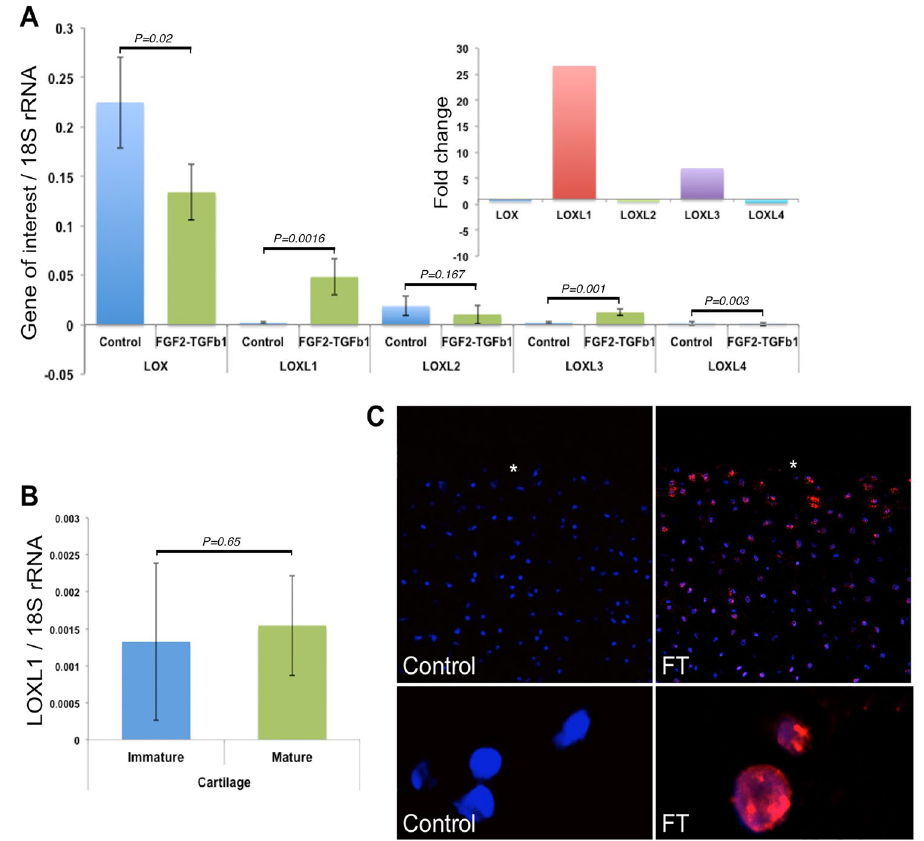
Figure 4. LOXL1 gene expression upregulation correlates with in vitro maturation of articular cartilage. Absolute gene expression values normalised to housekeeping gene 18S rRNA (in ng) for quantitative RT-PCR analysis of LOX isoform in control and in vitro growth factor-matured cartilage are shown ( A ). Relative values are also shown ( inset ). LOXL1 gene expression levels in freshly isolated immature and mature cartilage show no statistical difference ( B ). Rolling circle amplification in situ hybridisation shows LOXL1 gene transcription (red fluorescent labelling) is localised predominantly to the surface (white asterisk) of growth factor treated articular cartilage and is not detectable in untreated control cartilage where only nuclear counterstaining with DAPI is visible ( C ). The lower panel shows high magnification images of negative DAPI labelled nuclei and positively labelled (red)